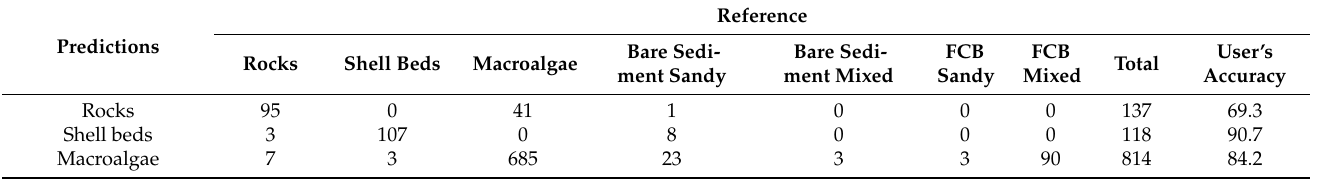
Table 3. Confusion matrix and independent validation statistics of the final random forest model, computed with the best set of predictors (14 predictors). All the values of the validation statistics range between 0 and 100%. FCB: fiddler crab burrow